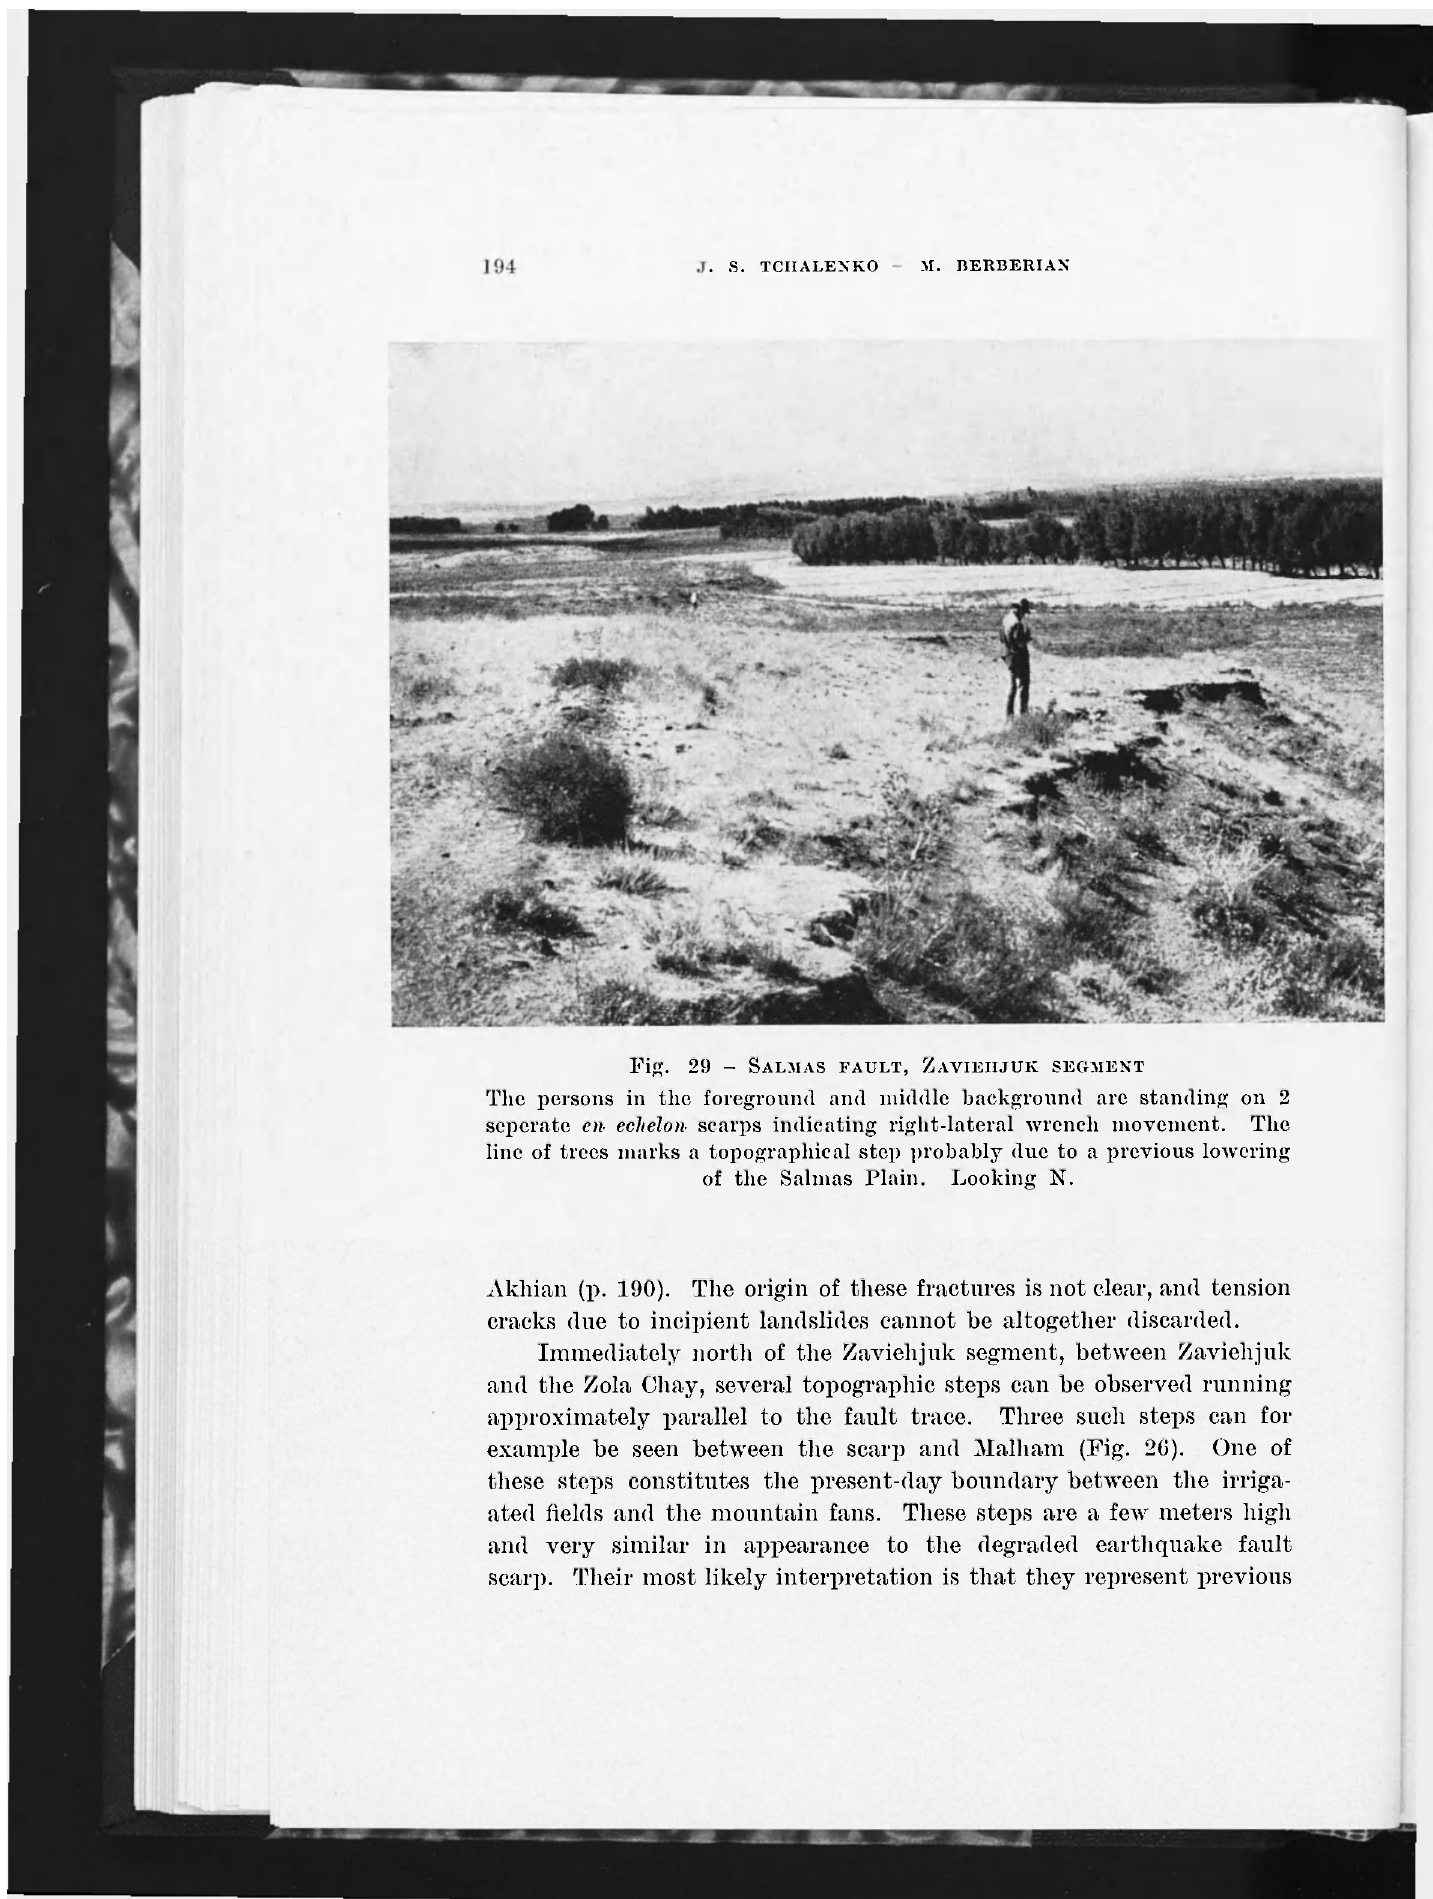
Fig. 29 - SALMAS FAULT, ZAVIEHJUK SEGMENT The persons in the foreground and middle background are standing on 2 seperate en echelon scarps indicating riglit-lateral wrench movement. The line of trees marks a topographical step probably due to a previous lowering of the Salmas